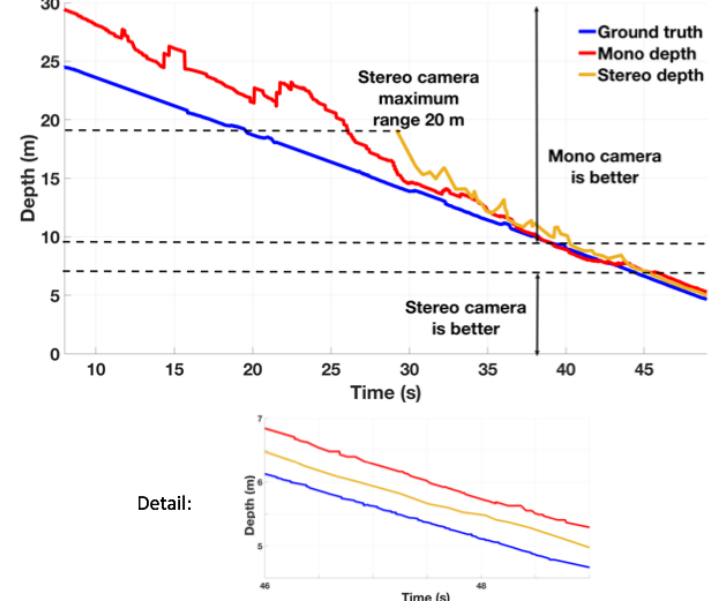
Figure 9. Depth estimation results for the stereo vision (amber) and motion parallax (red) approaches in the case of a head-on point feature when the LOS angle is between 1.1 and 4 ◦ . The ground truth is shown by the blue line. The camera resolution is set to full HD. The lower part emphasizes the results for depths less than 7